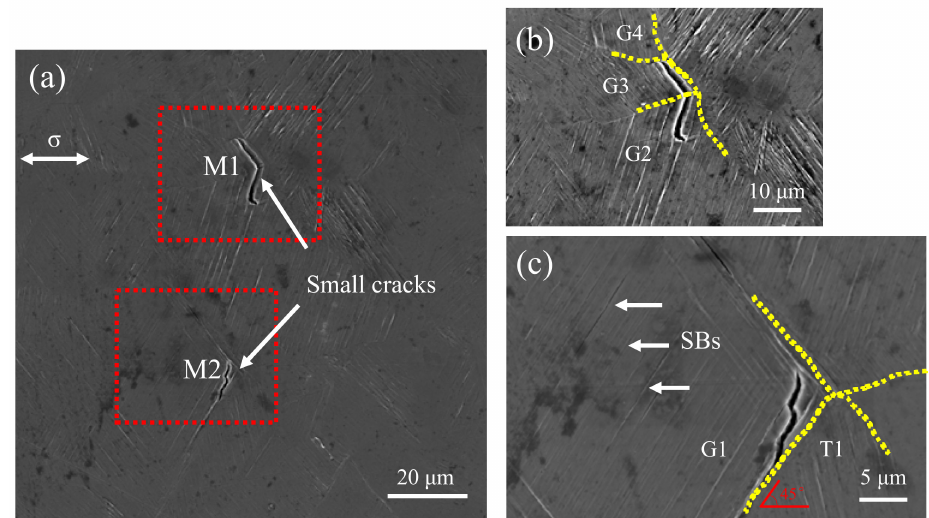
Figure 8. Morphology of small fatigue cracks and slip bands on the specimen surface after fatigue. ( a ) SEM image. ( b , c ) The enlarged image of red dashed box in ( a ). ( σ = 332